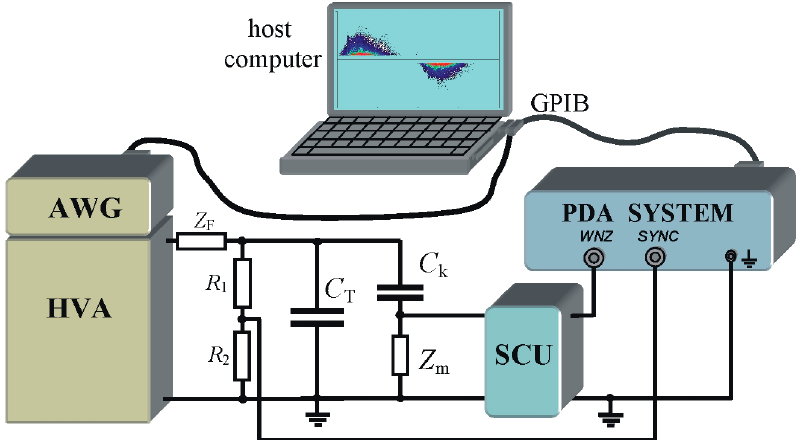
Figure 19. General block diagram of the laboratory system used for PRPD data acquisition: AWG — arbitrary waveform generator, HVA — high ‐ voltage amplifier, SCU — signal conditioning unit, PDA — PD Analyser, GPIB — IEEE.488 interface, C T — capacitance of tested object, C k — coupling capacitor, Z m — measuring impedance, R 1 / R 2 — HV divider, Z f — impedance of HV filter.